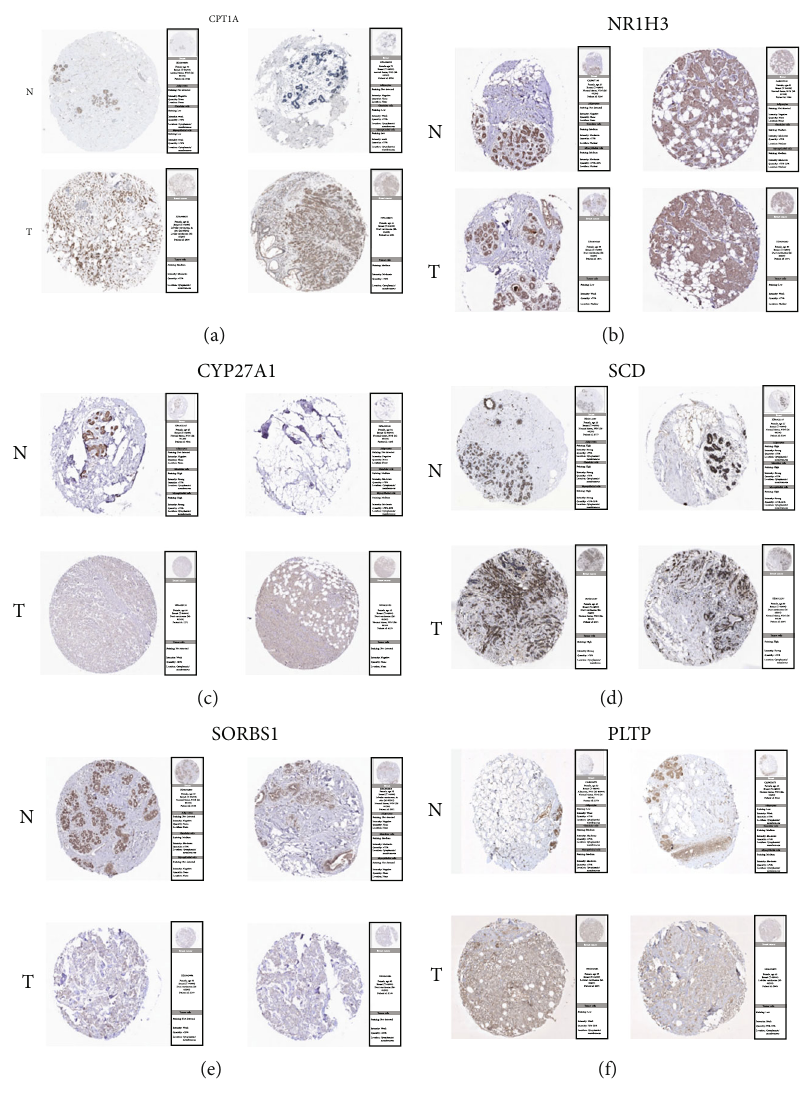
Figure 8: The results of immunohistochemistry. (a – f) The immunohistochemistry results showed the protein expression of CPT1A, NR1H3, CYP27A1, SCD, SORBS1, and PLTP in BRCA tissues and normal breast tissues.